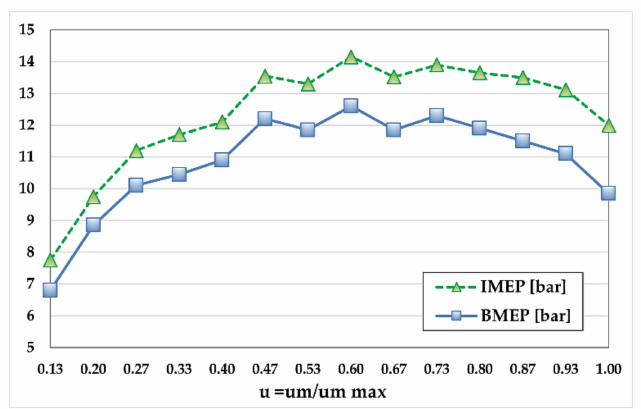
Figure 4. Brake ( BMEP ) and indicated ( IMEP ) mean effective pressure as functions of the normalized mean piston speed u , at full load conditions.